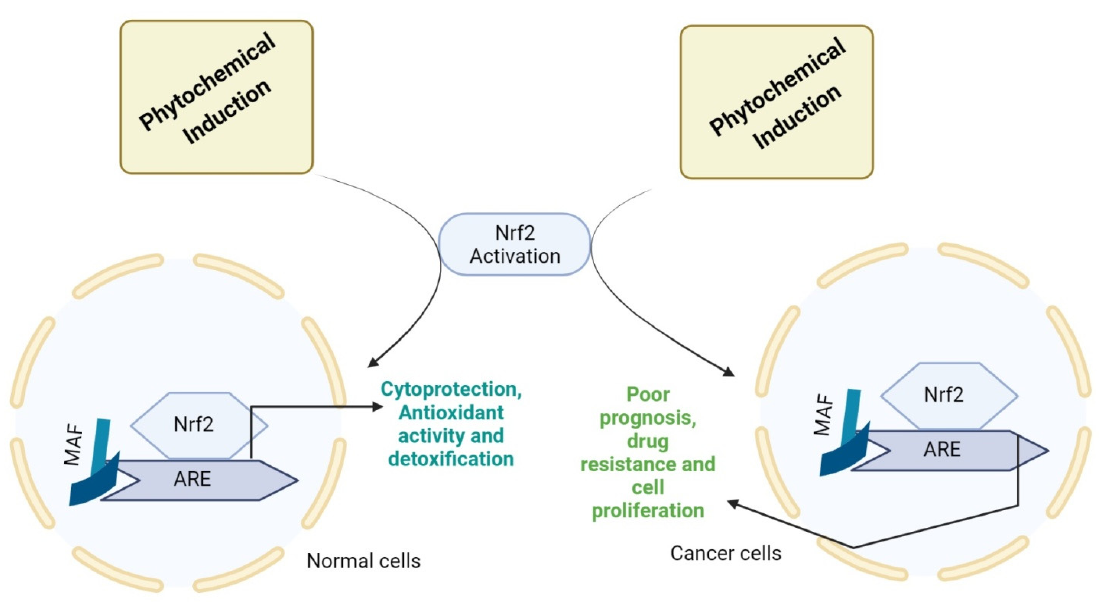
Figure 2. Nrf2 activation by phytochemicals leading to various events. MAF (musculoaponeurotic fibrosarcoma protein) activates antioxidant response genes by interacting with Nrf2 through ARE signaling, indicating that in response to electrophilic and oxidative stresses. In addition, in cancer cells, the imbalance in Nrf2/ARE signaling leads to drug resistance, poor prognosis, and cell proliferation. So, the consecutive Nrf2 activation might cope with the consequences in a positive manner.